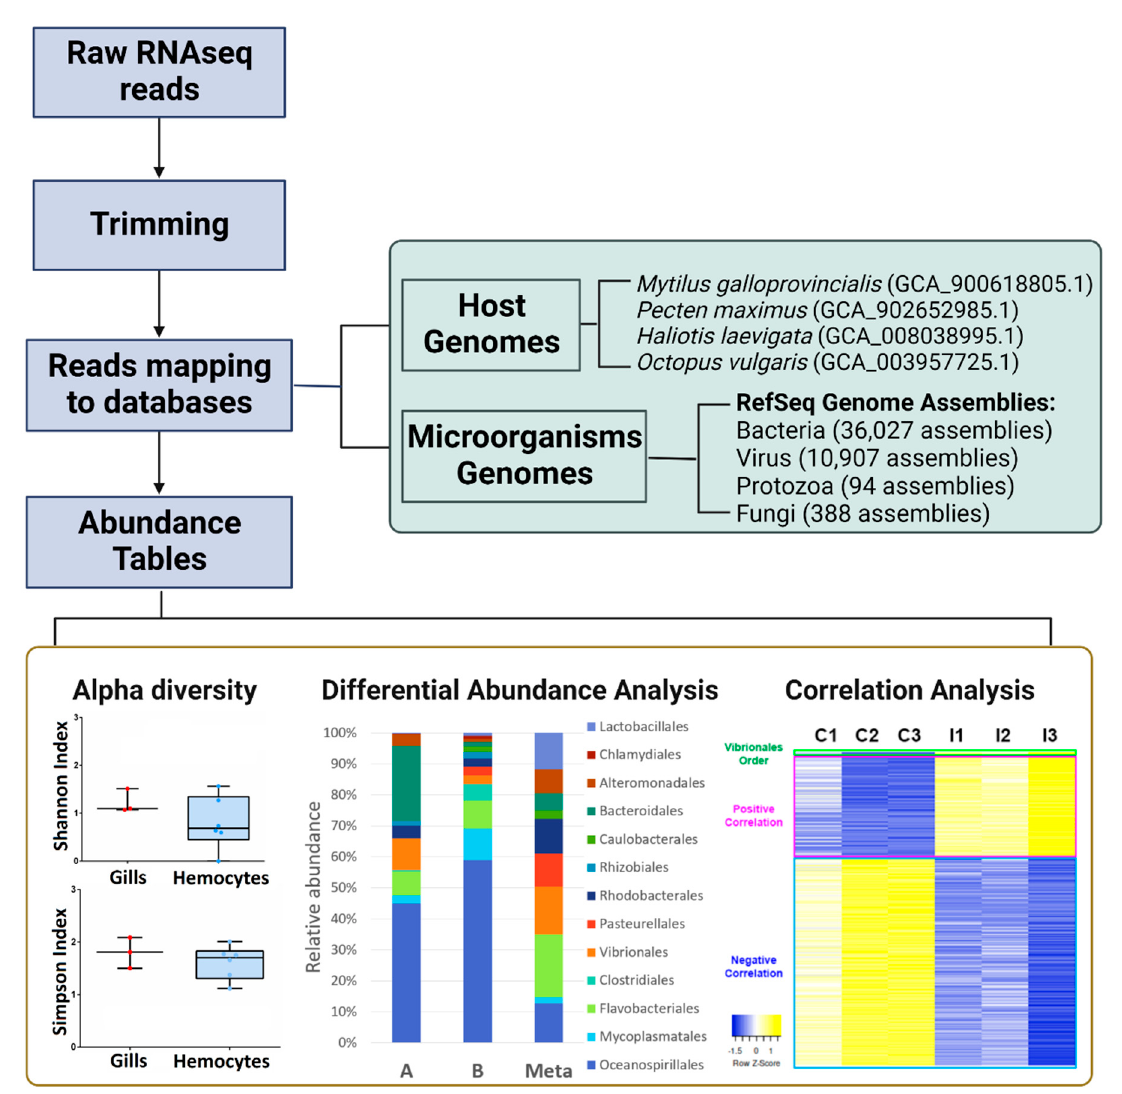
Figure 1. Working plan implemented for the study of metatranscriptomics.